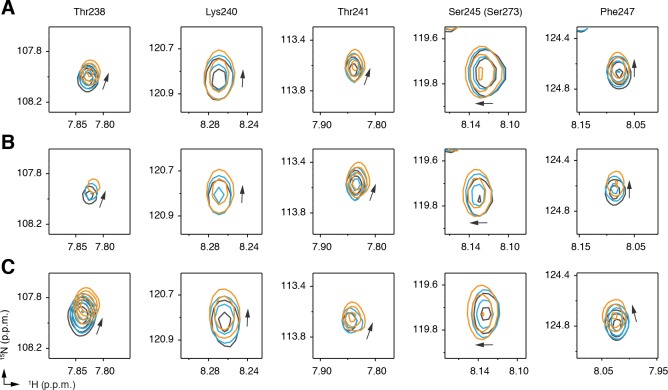
Differential 2D [1H,15N]-TROSY-HSQC NMR data focusing on residues in the Ser273 loop comparing C9 (1 and 3 equiv.; blue and orange, respectively) added into.(A) delipidated PPARγ bound to rosiglitazone (two equiv.; black); (B) native PPARγ bound to rosiglitazone (two equiv.; black); and (C) native PPARγ bound to edaglitazone (two equiv.; black).